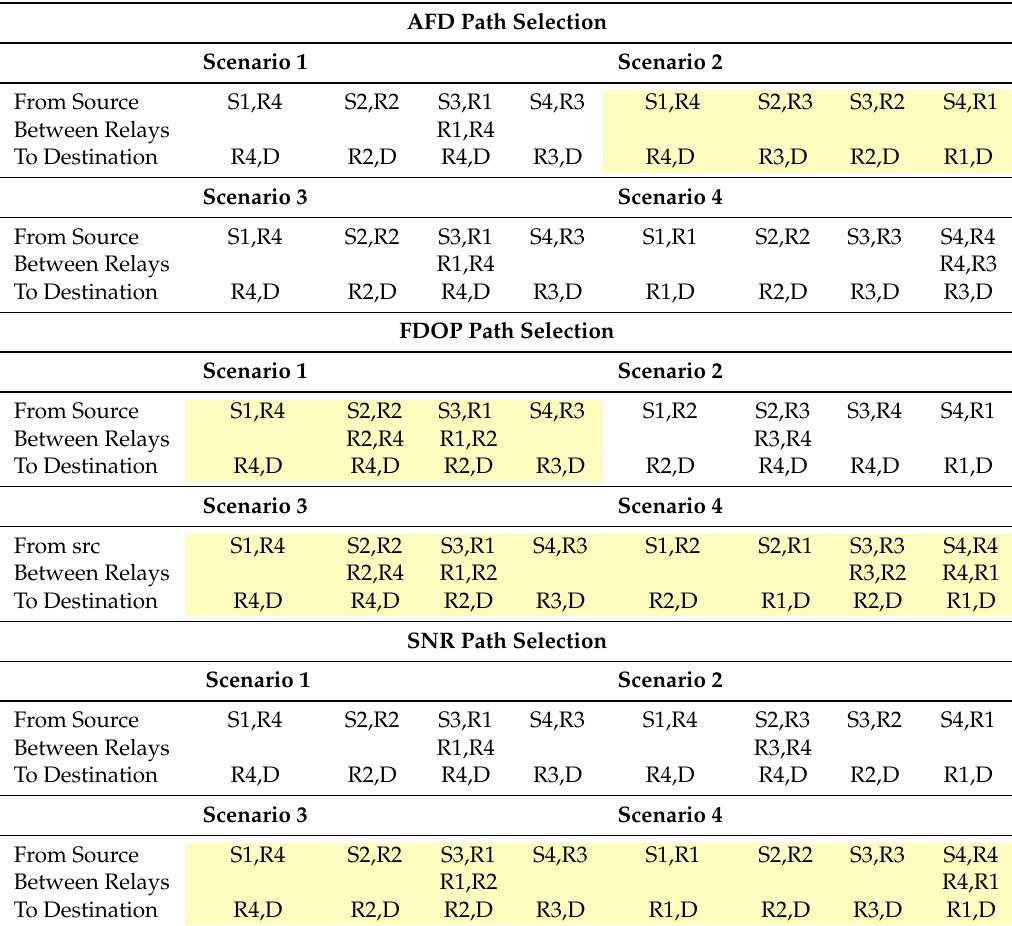
Table 2. Examples with Four Sources and Four